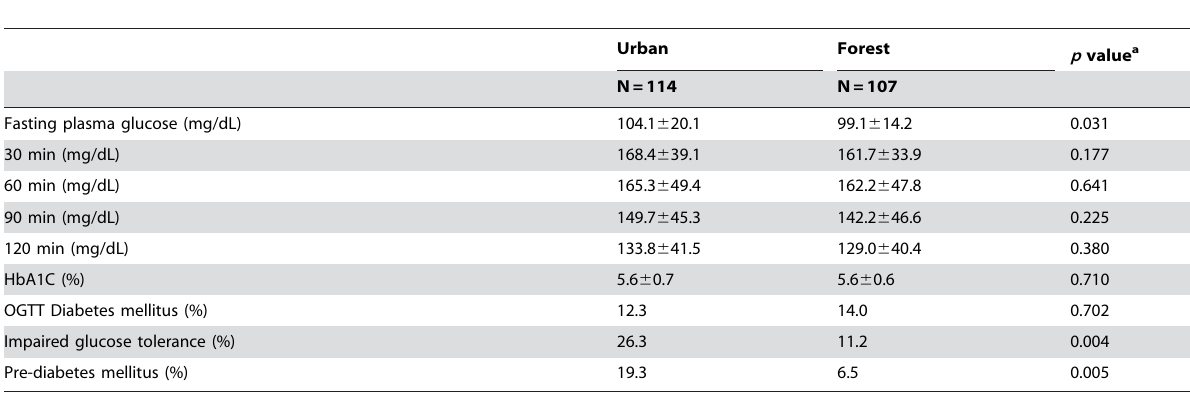
Table 2. Oral glucose tolerance test of urban and forest staff member